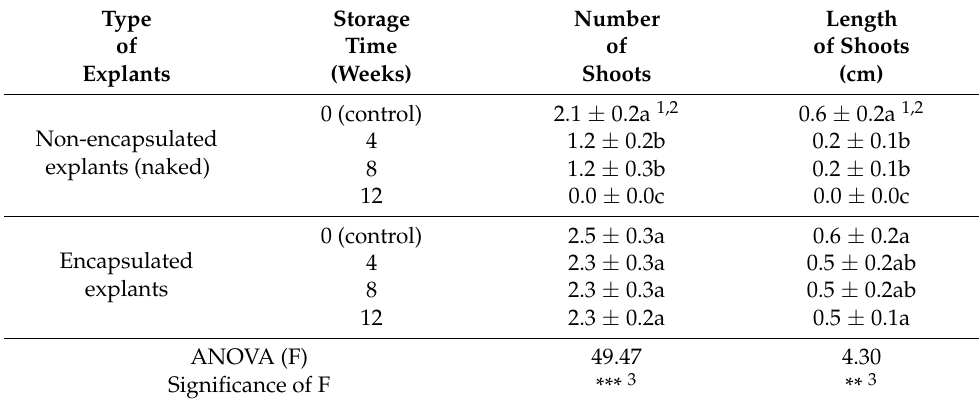
Figure 3. Effect of storage at 4 ◦ C for different time periods (weeks) on subsequent regeneration responses (%) of encapsulated and non-encapsulated shoot tip explants of G. jasminoides , on MS nutrient medium with 1 µ M IAA and 5 µ M BAP, after 4 weeks of culture. Means ± SD ( n = 45) followed by different letters are significantly different according to Duncan’s multiple range test at p ≤ 0.05. Table 4. Effect of storage at 4 ◦ C for different time periods (weeks) on subsequent shoot formation of encapsulated and non-encapsulated shoot tip explants of G. jasminoides , on MS nutrient medium with 1 µ M of IAA and 5 µ M of BAP, after 4 weeks of